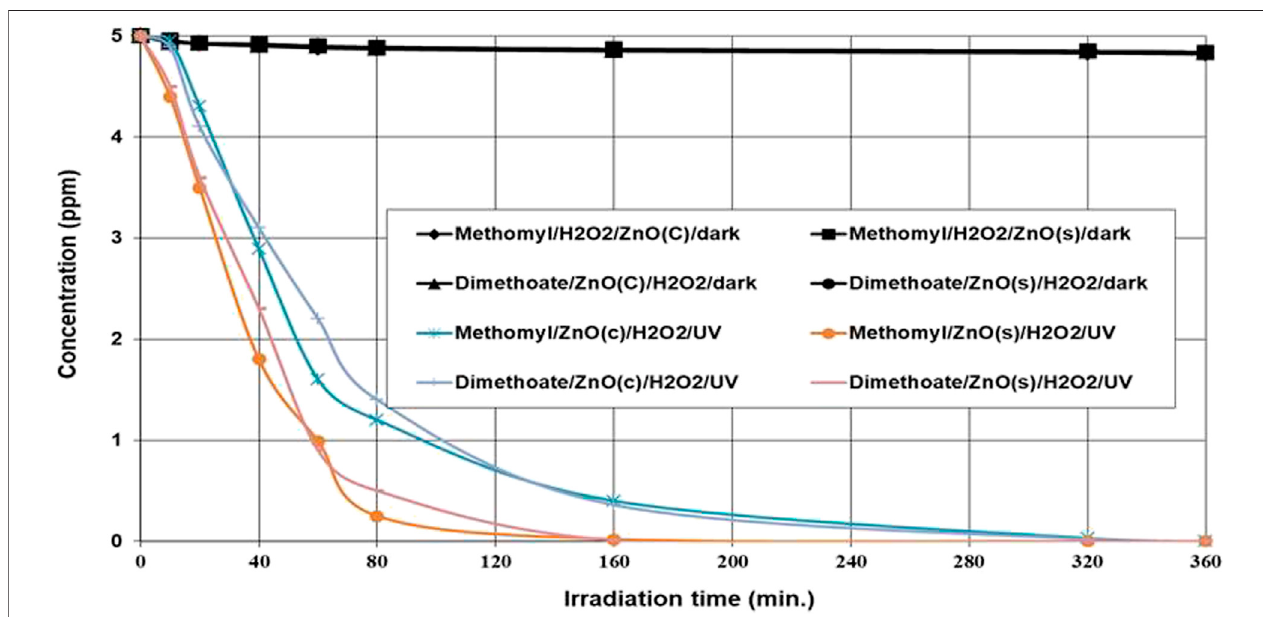
FIGURE 6 | Photocatalytic degradation of dimethoate and methomyl at an initial concentration of 5 ppm under ZnO(s)/H 2 O 2 /UV and ZnO(c)/H 2 O 2 /UV systems.